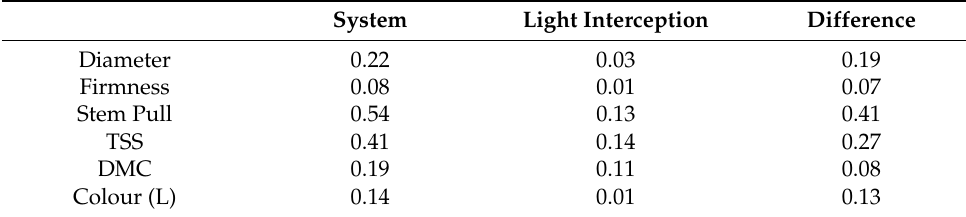
Table 7. Overall increase in r 2 (proportion of variation explained) due to system and light interception variables, in respective two-way ANOVA models (season is the other variable in each model). The values shown are the effects of both the corresponding variable and its interaction with season, over and above the r 2 due to season alone. For example, the r 2 increase for the system of 0.22 shown in the first row of the table can be obtained from the values in Panel A of Table 6 corresponding to the “cumulative r 2 ” value in the interaction column minus the “r 2 ” of the season effect alone (0.57 − 0.35 =